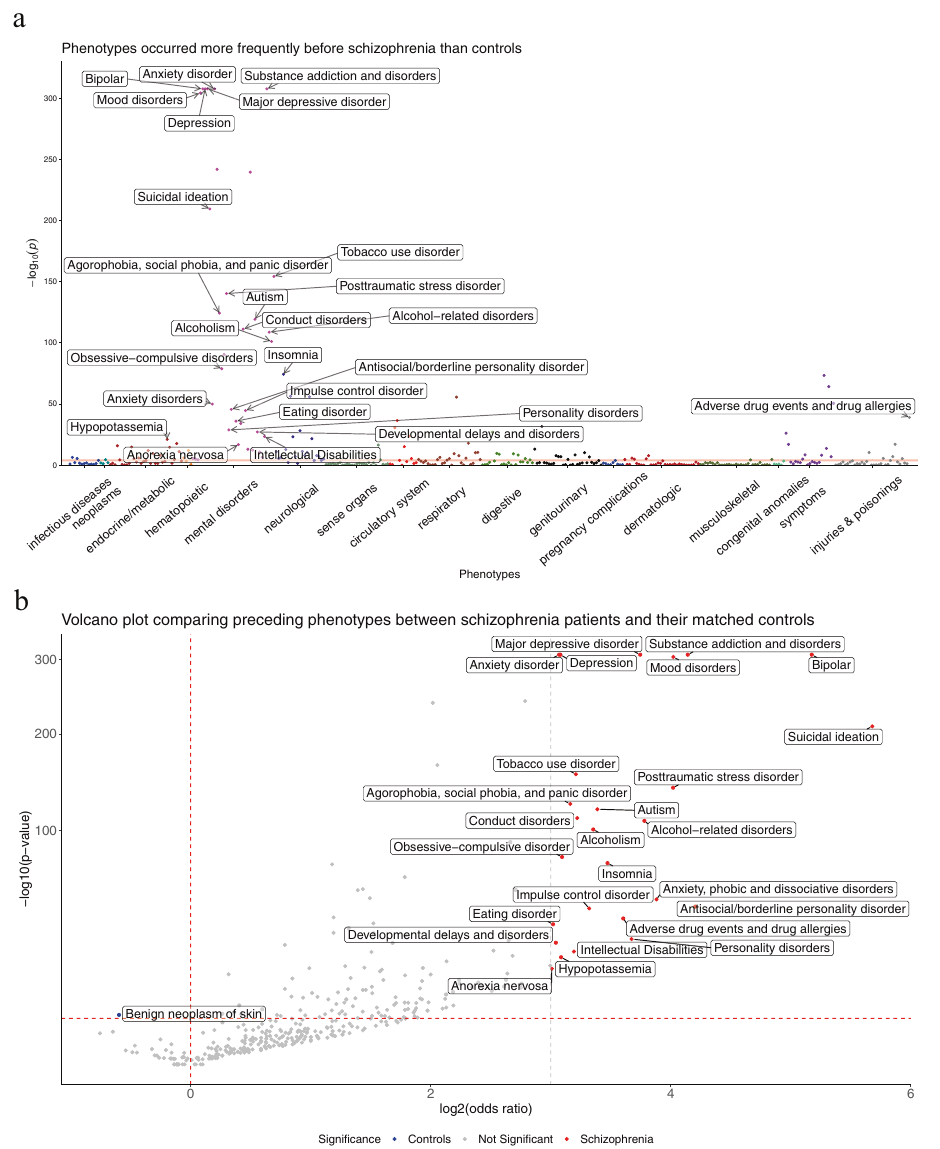
Fig. 1 Systematic analysis of phenotypes preceding a diagnosis of schizophrenia. a Manhattan plot of the phenotypes, grouped by disease categories. The red horizontal line indicates a Bonferroni-corrected P -value threshold. Phenotypes with odds ratios (OR) > 8 are annotated. b Volcano plot of P -value (in − log 10 ) versus the OR (in log 2 ). The red horizontal dashed line indicates the same Bonferroni-corrected P -value threshold, the red vertical dashed line designates OR = 1, and the gray vertical dashed line indicates an OR = 8 threshold, above which phenotypes enriched in the schizophrenic group are with the highest hazard ratios after the fi rst diagnosis of Further strati fi cation by sex revealed that women who later schizophrenia in the dataset. We tested Cox proportional hazard developed schizophrenia are more likely to have type 2 diabetes, assumptions using the survminer R package, and only one (316: obstructive sleep apnea, and eating disorders, while men who Substance addiction and disorders) of the top ten phecodes later developed schizophrenia are more likely to have conditions failed the proportionality assumption after Bonferroni correction such as acute renal failure, developmental delays, and rhabdo- of test p -values. Sex-strati fi cation analysis shows that women myolysis (Supplemental Table 2 and 3). with schizophrenia are more likely to develop encephalopathy, epilepsy, and adverse drug events and allergies, while men with schizophrenia are more likely to develop impulse control disorder, esophageal bleeding, and acute osteomyelitis (Supple- Using a Cox proportional hazard model, we found 402 phecodes mental Tables 4 and 5). are signi fi cantly enriched (Bonferroni-corrected P -value < 0.05) in We further investigated disease risks strati fi ed by three age the schizophrenic group following the disease onset (Fig. 2), with groups: 15 – 29 years old (adolescents and young adults; 13,828 24 phecodes signi fi cantly enriched in controls after their index patients), 30 – 59 years old ( “ middle-aged ” adults; 16,339 patients), dates. The results are summarized in the Manhattan plot and and 60 years old and above (older adults; 31,286 patients). volcano plot in Fig. 2a, b. Table 2 shows the top ten phenotypes